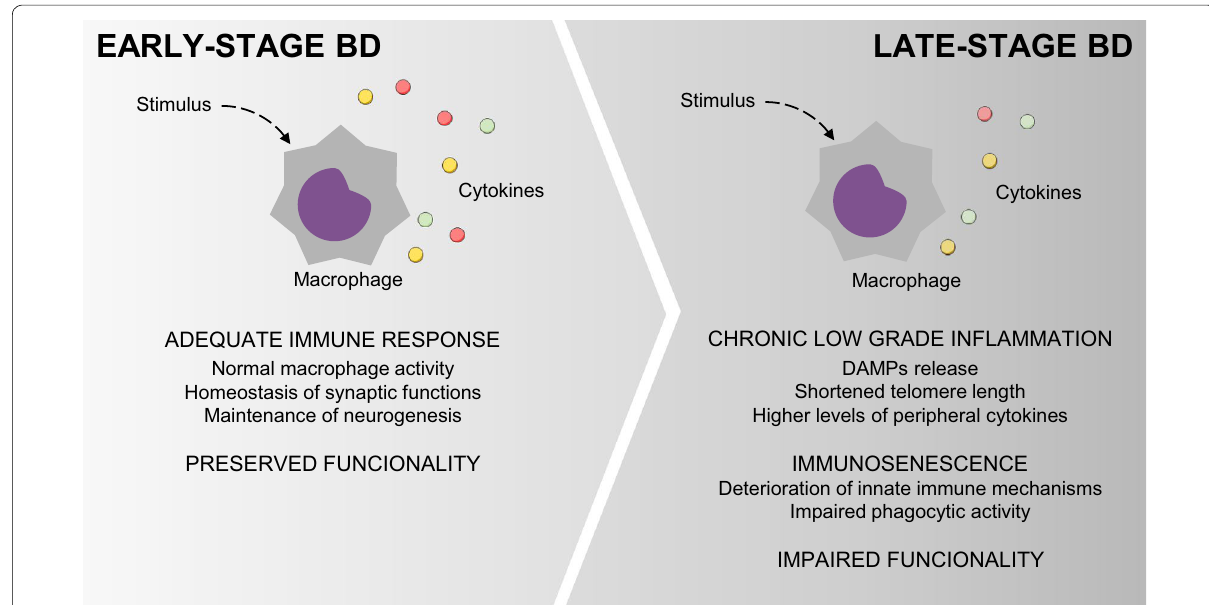
Fig. 6 Macrophage activity impairment occurs in parallel with the progression of BD. Cell death, DAMPs release, telomere shortening, and proinflammatory mediators might lead to a chronic state of immune dysfunction, with a consequent decline in critical cellular processes.